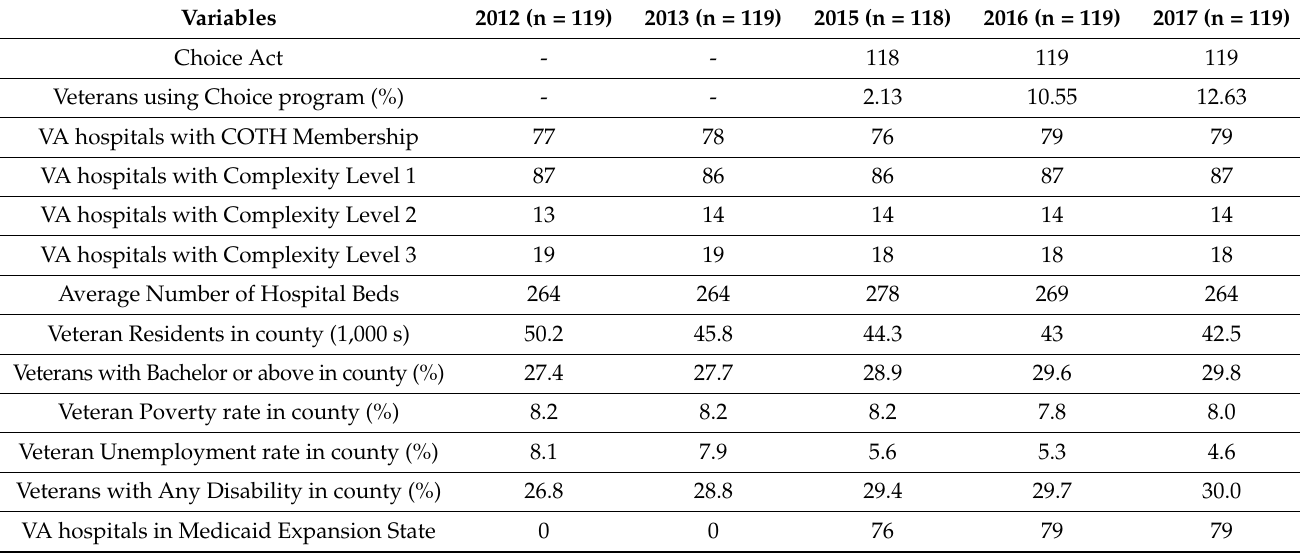
Table 2. Characteristics of Samples by